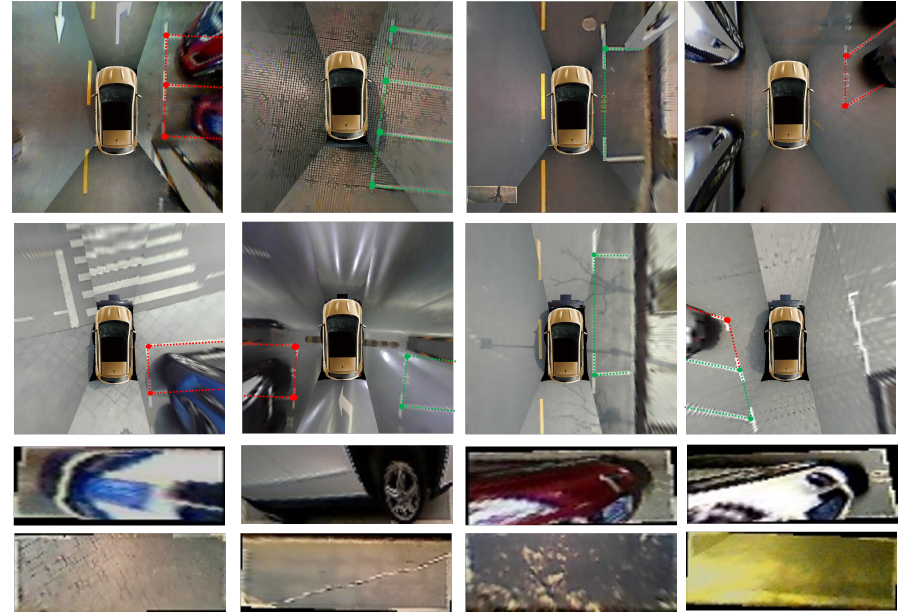
Figure 10. Cases of datasets used in evaluation. Rows 1 and 2 are the annotation information that was labeled for ps2.0 and PSV datasets. The green indicates the vacant parking slot. The red indicates the non-vacant parking slot. Rows 3 and 4 are parking slot samples that were cut and warped according to the annotation